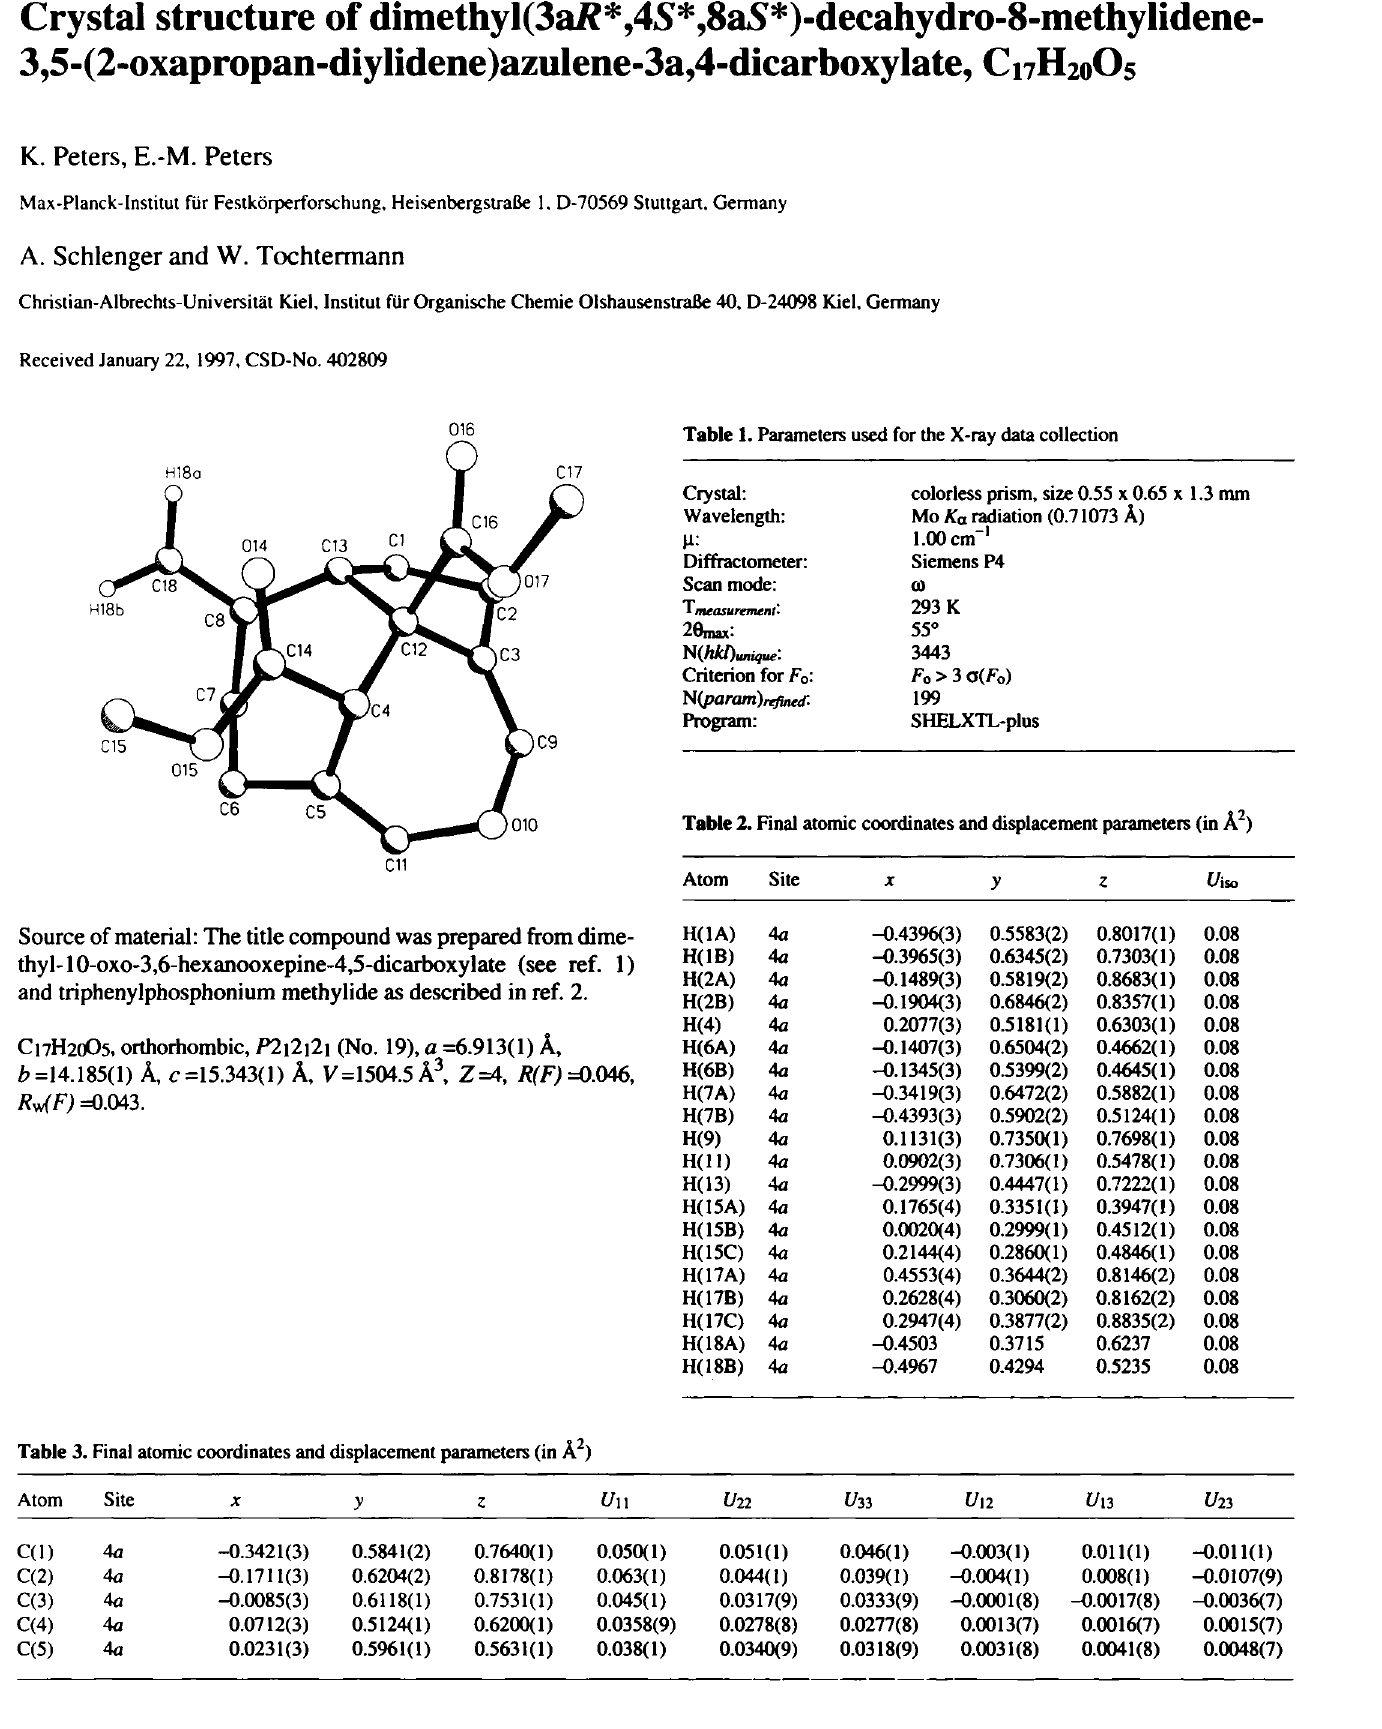
Table 3. Final atomic coordinates and displacement parameters (in A^) Atom